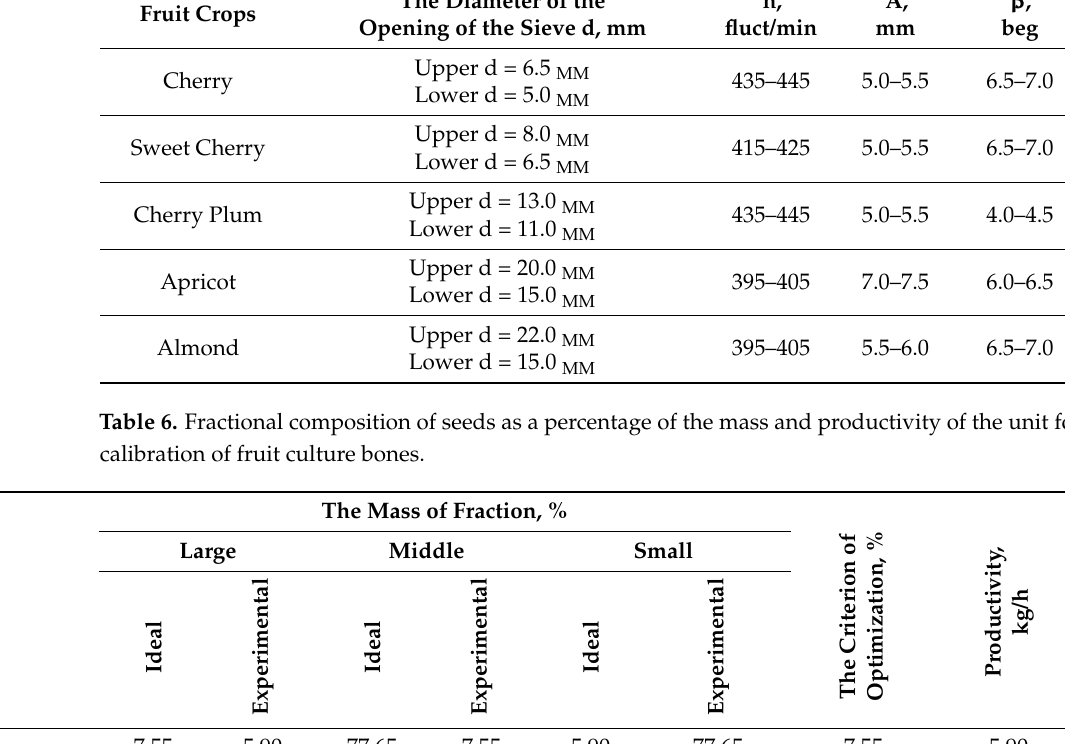
Table 5. Rational parameters and modes of calibration of seeds of fruit stone crops. Fruit Crops